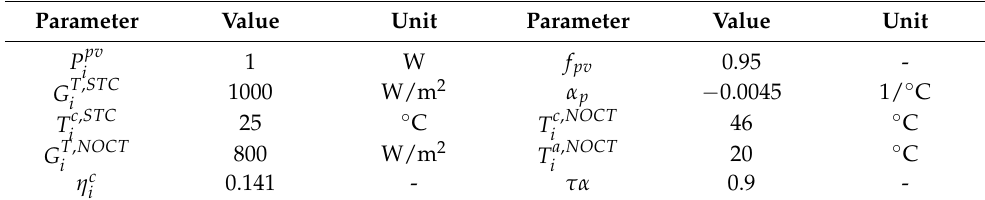
Table 1. Parametric information regarding PV generation